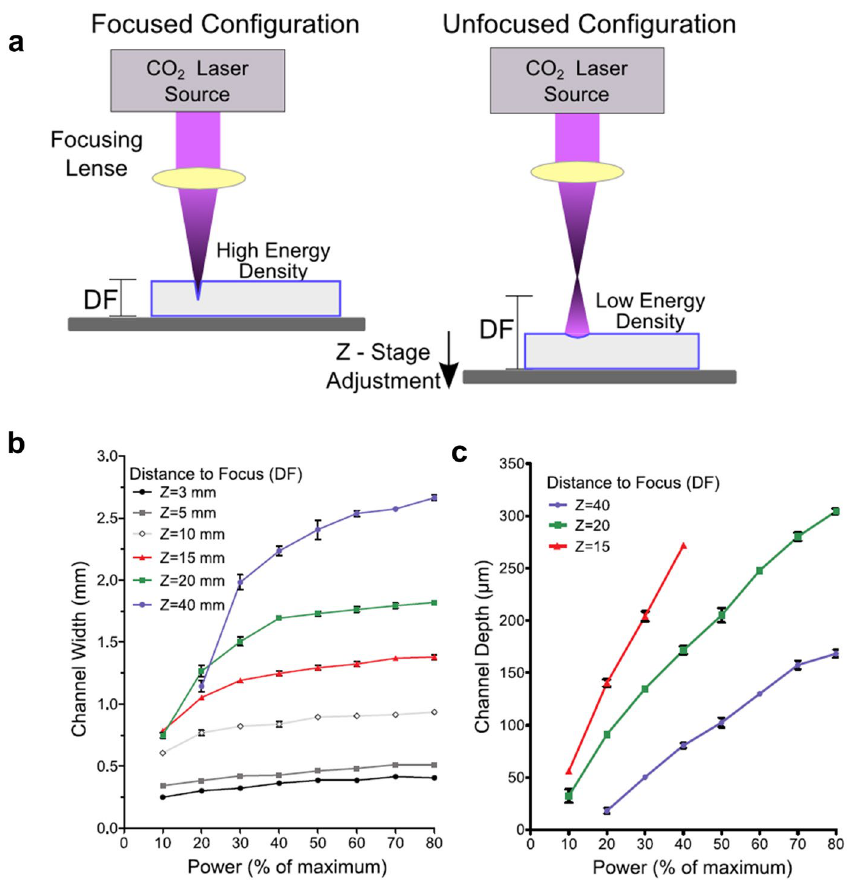
Figure 1. Characterisation of the laser ablation. ( a ) Laser ablation process in the focused and unfocused configuration. Increasing the distance between the focal point and the surface of the material causes the laser energy to be spread over a wider area, resulting in lower energy density. Adjustments of the stage and laser source enable control of the laser. Channel width ( b ) and depth ( c ) of channels engraved in PMMA resulting from different combinations of laser power (as percentage of the maximum 30 W) and distance-to-focus (3, 5, 10, 15, 20 and 40 mm) as extracted from profilometric analysis (mean ± SD, n =